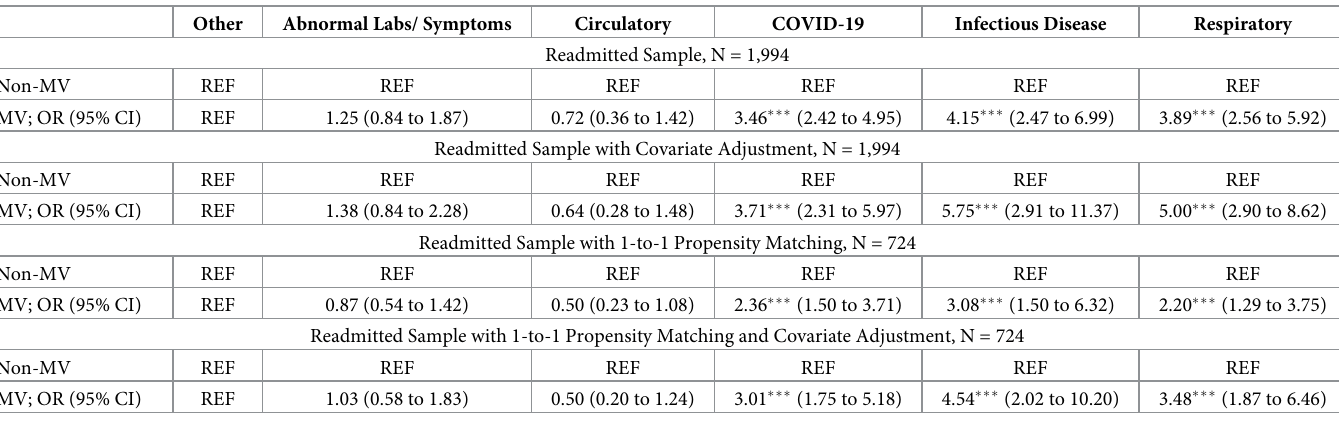
Table 4. Multinomial logistic regression for reason for